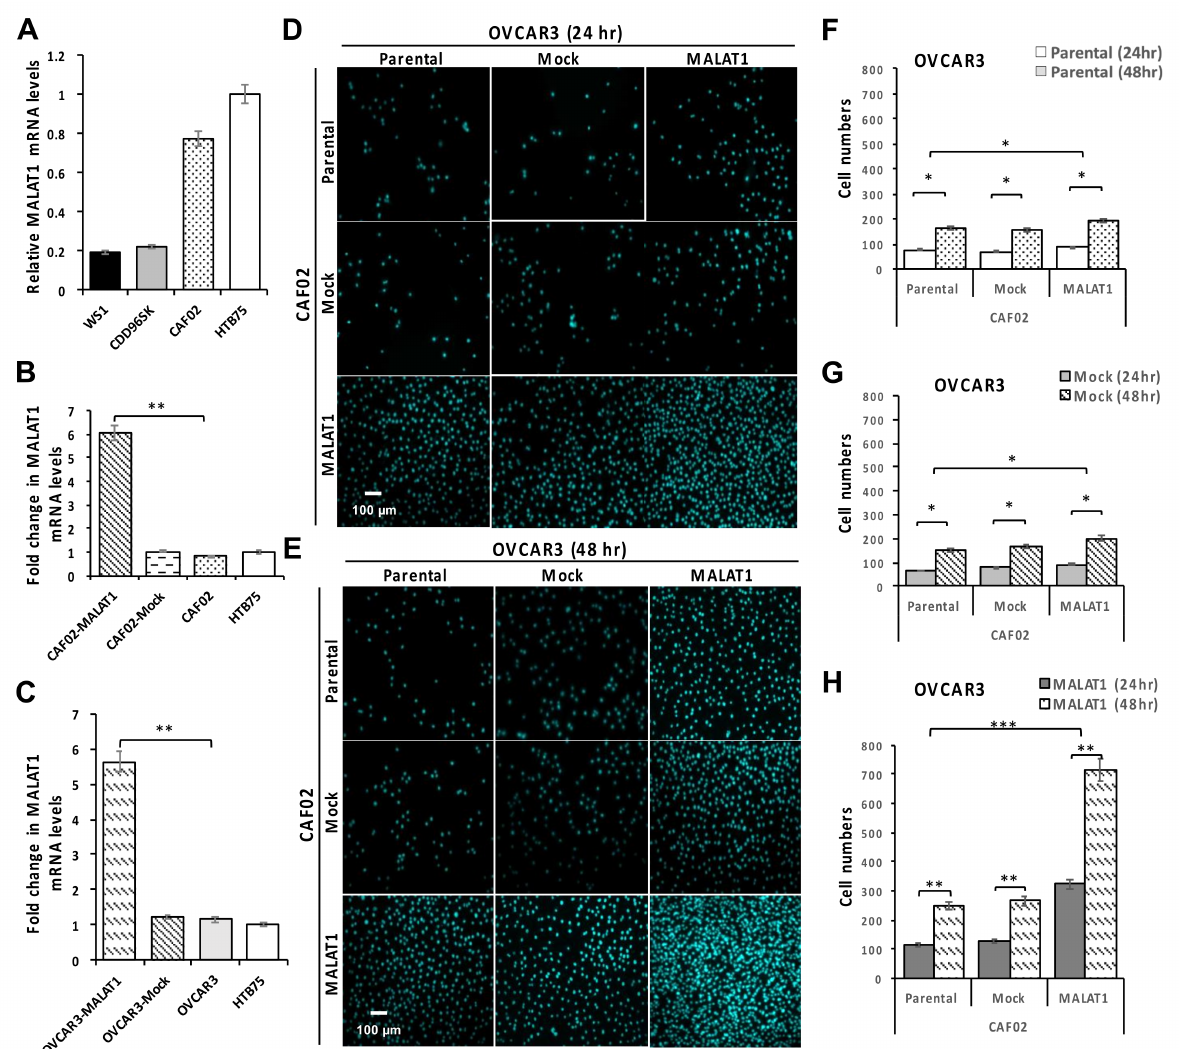
Figure 5. Overexpression of MALAT1 in CAF02 fibroblasts induces OVCAR3 cell invasion: Representative ( A ) original levels of MALAT1 detected by an RT-qPCR analysis. ( B , C ) Changes in MALAT1 detected by an RT-qPCR analysis following transduction ( D – H ) overexpression of MALAT1 in CAF02 fibroblasts and OVCAR3 ovarian cancer (OC) cells respectively increased OVCAR3 cell invasive abilities (* p < 0.05; ** p < 0.01; *** p < 0.001). The experiment was repeated at least three